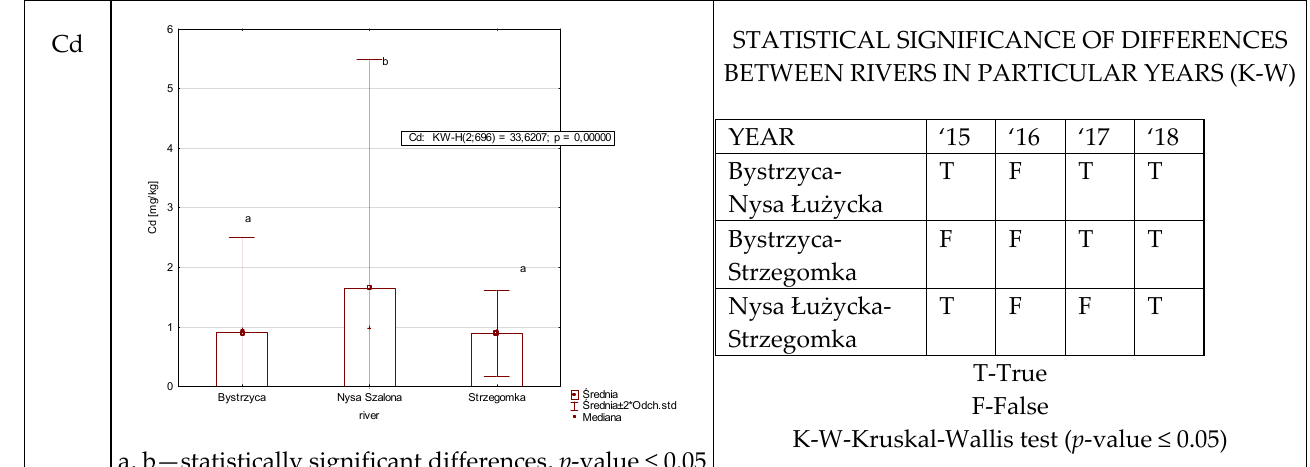
Figure 3. Cd concentration in plants from rivers across 29 sites depending on river (graph to the ( left )) and by year 2015–2018 in the table to the ( right ). Statistically significant differences are marked in the graph with letters a, b and in the table these differences are shown by year between rivers—T—differences were present, F—no statistical difference ( p -value ≤ 0.05).